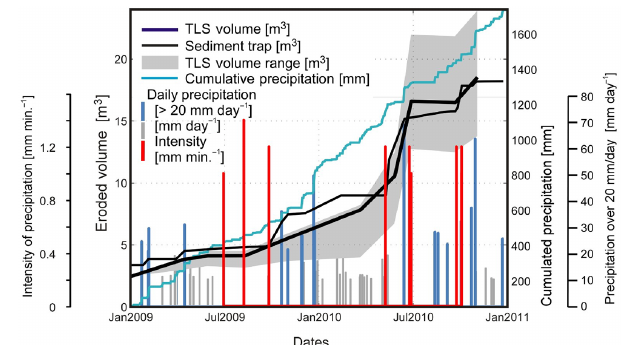
Figure 7. Cumulated TLS-measured volumes (in bold black line) against cumulated calibration on sediment-trap-measured volumes (thin black line) for the years 2009 and 2010. In addition, the cumu- lative precipitation is shown as well as the daily precipitation events (in grey) and the main daily precipitation events that are considered as significant in red (>20mmday − 1 ) and the largest-intensity event above 10mmmin − 1 sampled with a tipping-bucket rain gauge. The initial sediment delivery is not zero because we used the storage in the sediment trap of the previous period as the initial